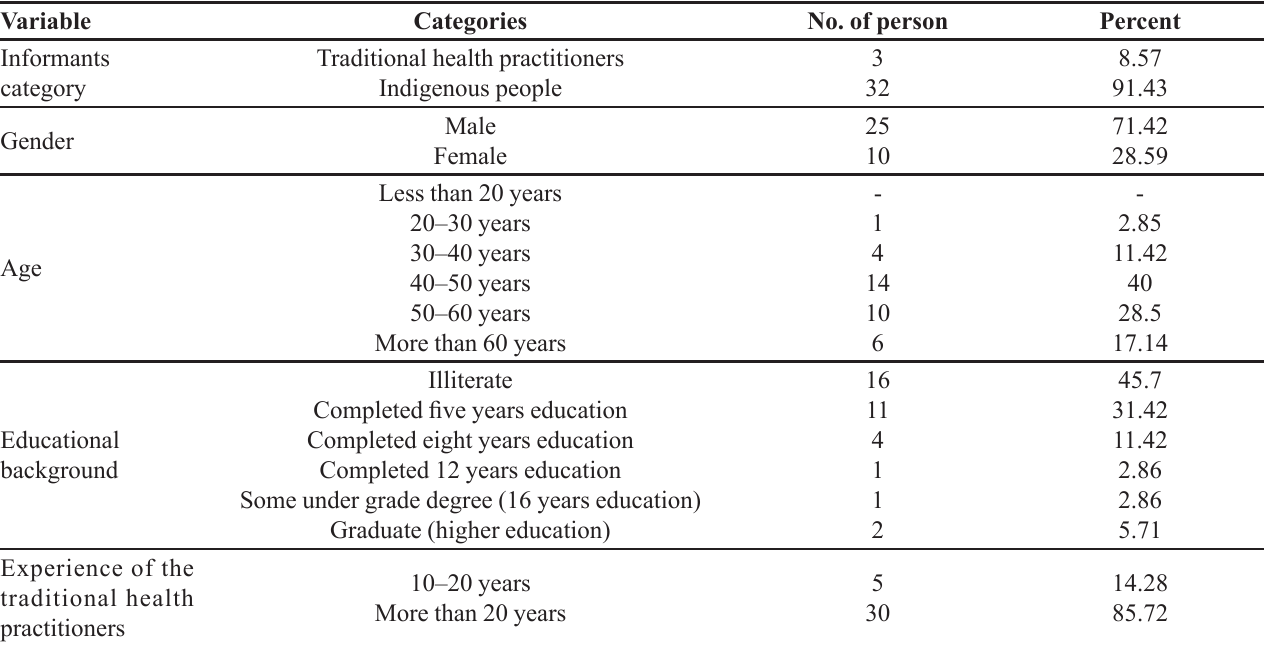
TABLE I - Demographic data of the